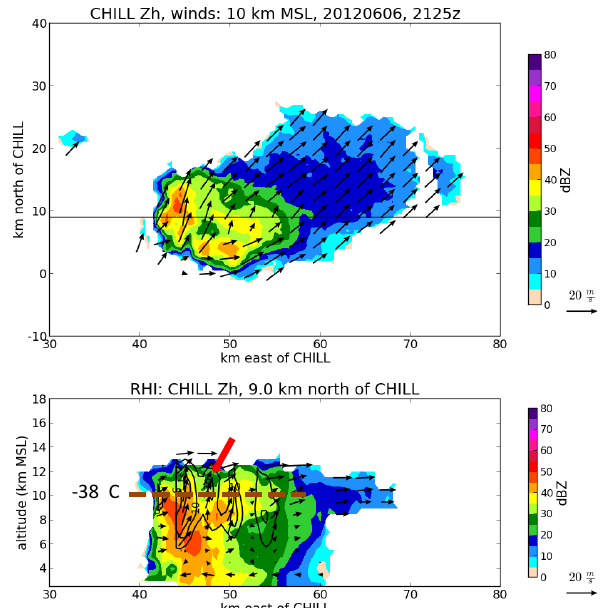
Fig. 13. Dual Doppler analysis of the wind and reflectivity field for the southern storm at 21:25UTC. Contour lines of updraft strength at 5, 10 and 15ms − 1 are included. The approximate location of the ambient − 38 ◦ C level is shown by the dashed line. The red arrow depicts an area of increasing updraft at temperatures colder than − 38 ◦